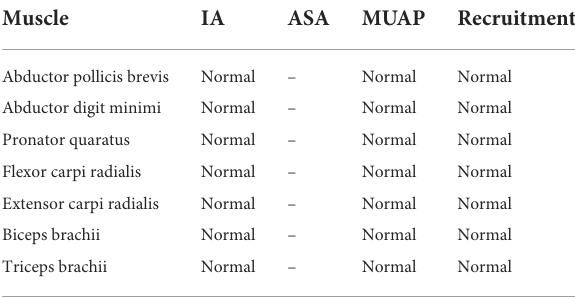
TABLE 2 Findings of needle electromyography in right upper